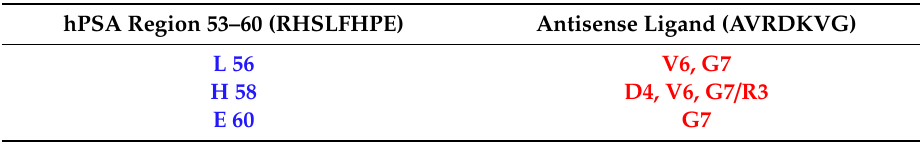
Figure A1 . hPSA—AVRDKVG docking is accurately predicted using: ( a ) The pepATTRACT web Figure A1. hPSA—AVRDKVG docking is accurately predicted using: ( a ) The pepATTRACT web server, and ( b ) CABS-dock server [47,48]. server, and ( b ) CABS-dock server [47,48]. Table A1. Amino acid pairs of the receptor (blue)–peptide (red) complex, at a distance closer than 4.5 Å, Table A1. Amino acid pairs of the receptor (blue)—peptide (red) complex, at a distance closer than predicted by CABS-dock server for flexible protein–peptide docking 4.5 Å, predicted by CABS-dock server for flexible protein—peptide docking [48].